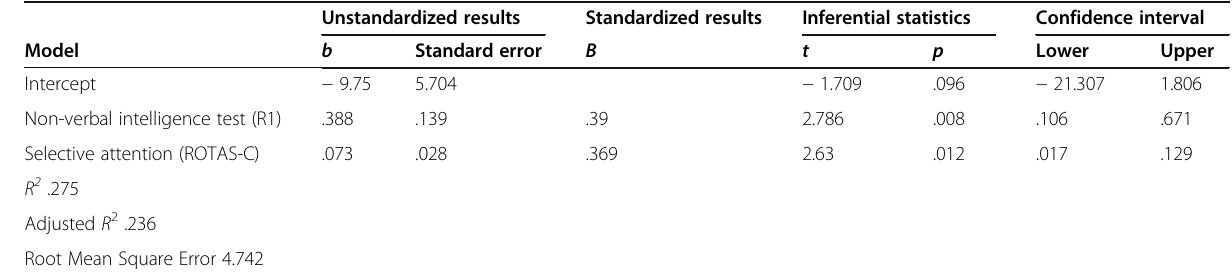
Table 4 Final multiple linear regression